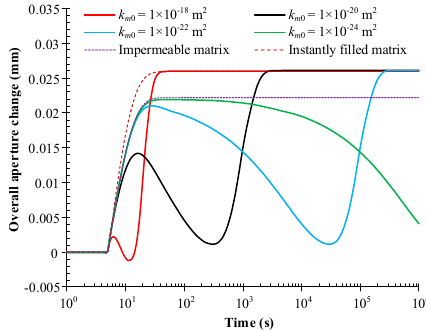
Figure 12. Evolution of fracture aperture change for different initial matrix permeabilities.